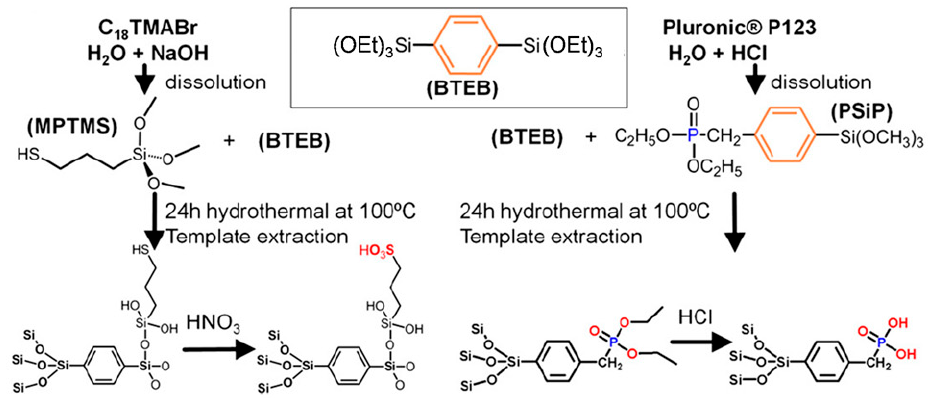
Figure 2. SEM images of PMOs with different morphologies ( a – i ). Reprinted from Reference [80]; copyright (2006) with permission from Elsevier.